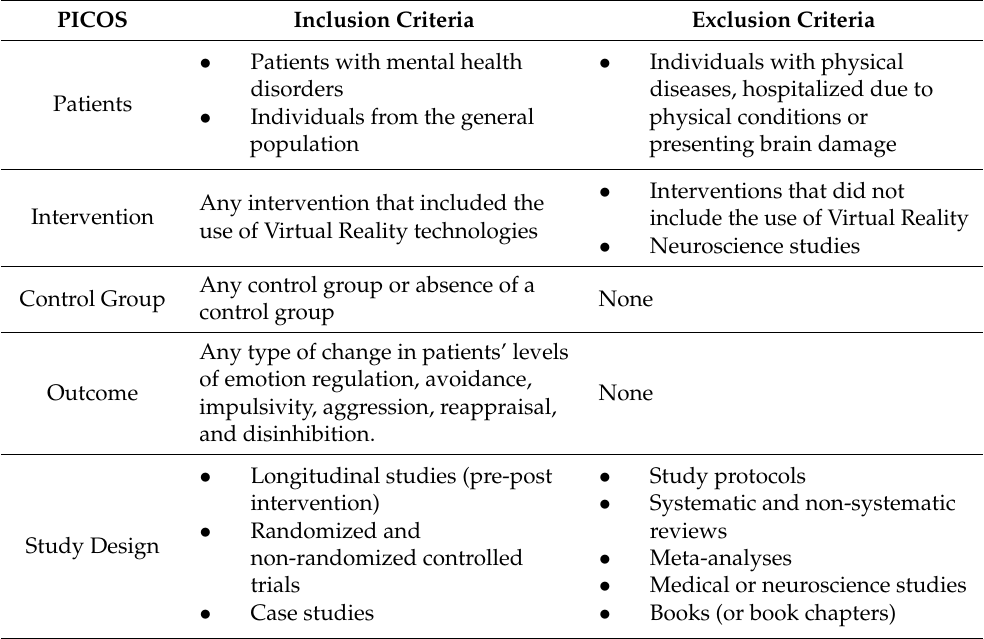
Table 1. Population, Intervention, Comparison, Outcomes and Study (PICOS) table for inclusion and exclusion criteria